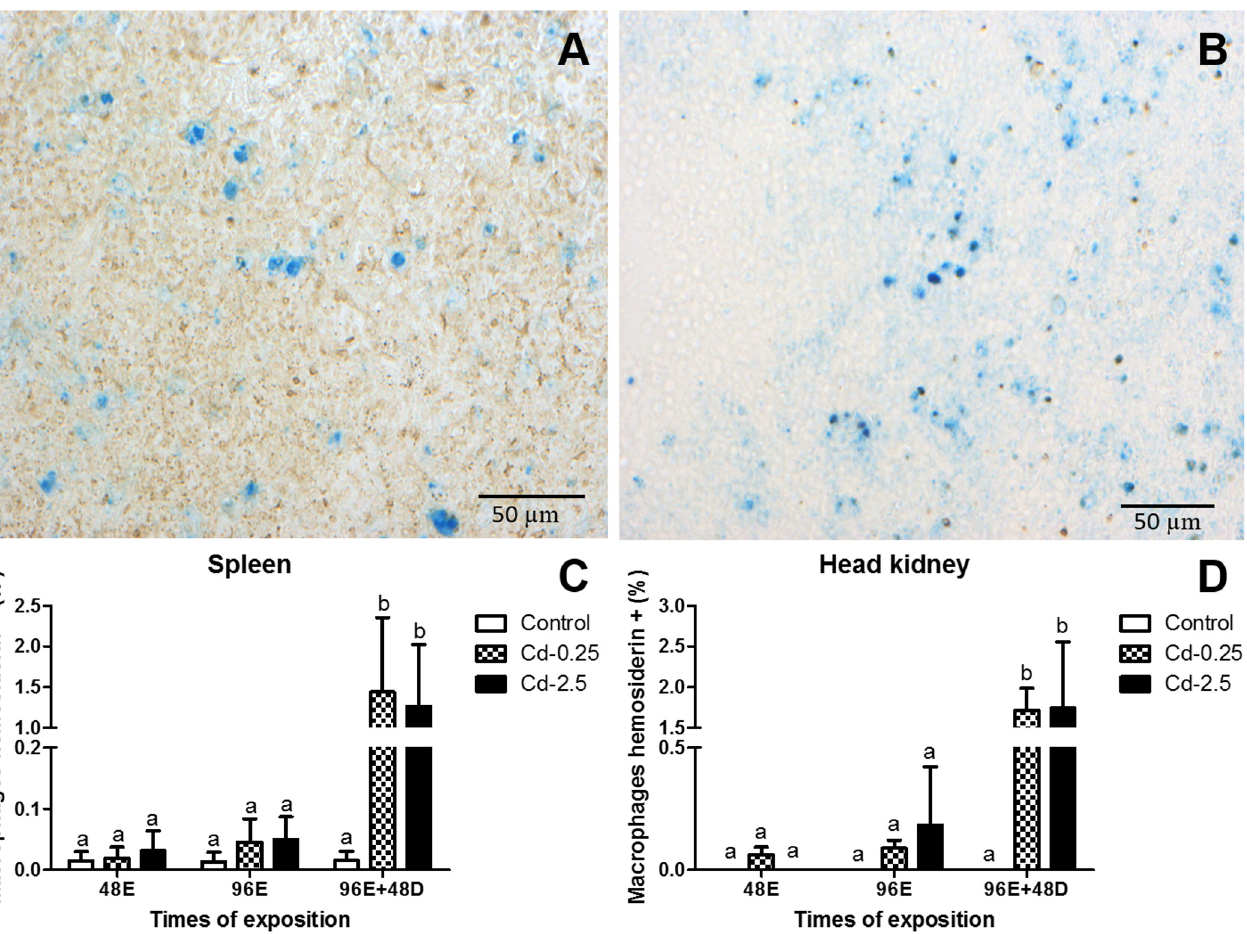
Fig 8. Single macrophages of spleen and head kidney of O . niloticus stained by Pearls ’ histochemical technique. (A, B) Pigment-containing granules predominantly labeled with hemosiderin (blue). (C, D) Percentage of labeling for hemosiderin submitted to different treatments. Values followed by different letters differ by ANOVA and Bonferroni post test (p <